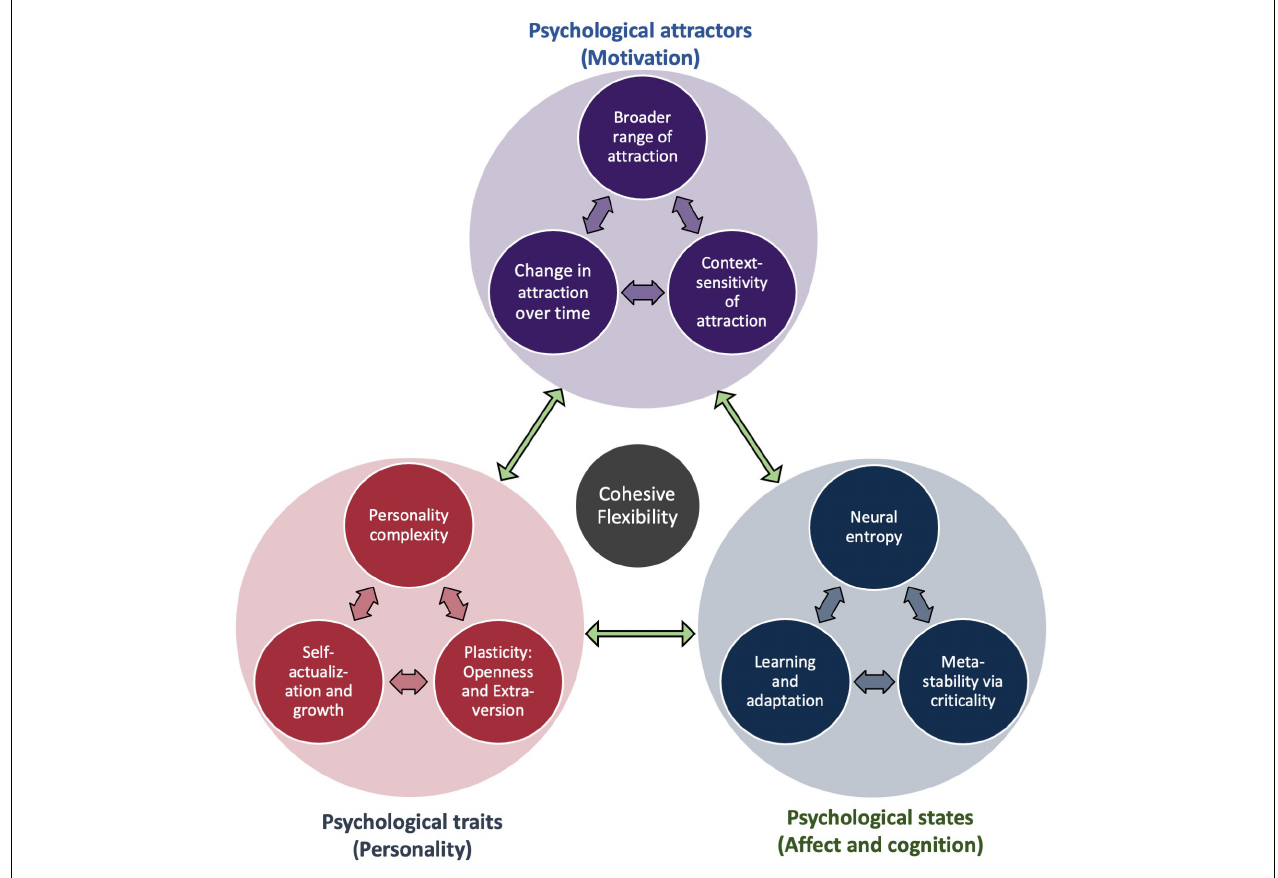
FIGURE 11 | Cohesive flexibility and multi-scale psychology. This diagram illustrates how cohesive flexibility may provide a functional bridge between moment-to-moment changes in psychological states, more enduring psychological traits, and the attracting states by which individuals evolve through time as cybernetic (free energy minimizing) systems. At each level of organization, flexible (potentially self-organized critical) dynamic processes allow for intelligent responding, learning, and evolution toward increasing degrees of adaptive